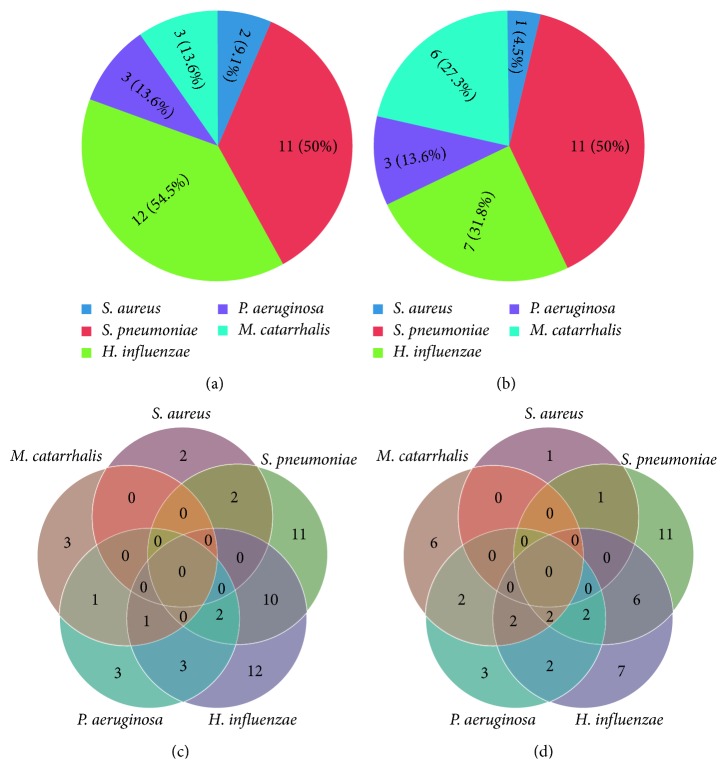
Bacterial detection in tonsils of patients with higher hypertrophy. The graph shows the frequency of bacterial detection in tonsils (a) and in adenoids (b). The graph shows the patients who presented bacterial codetection in the (c) tonsils and in adenoids (d).